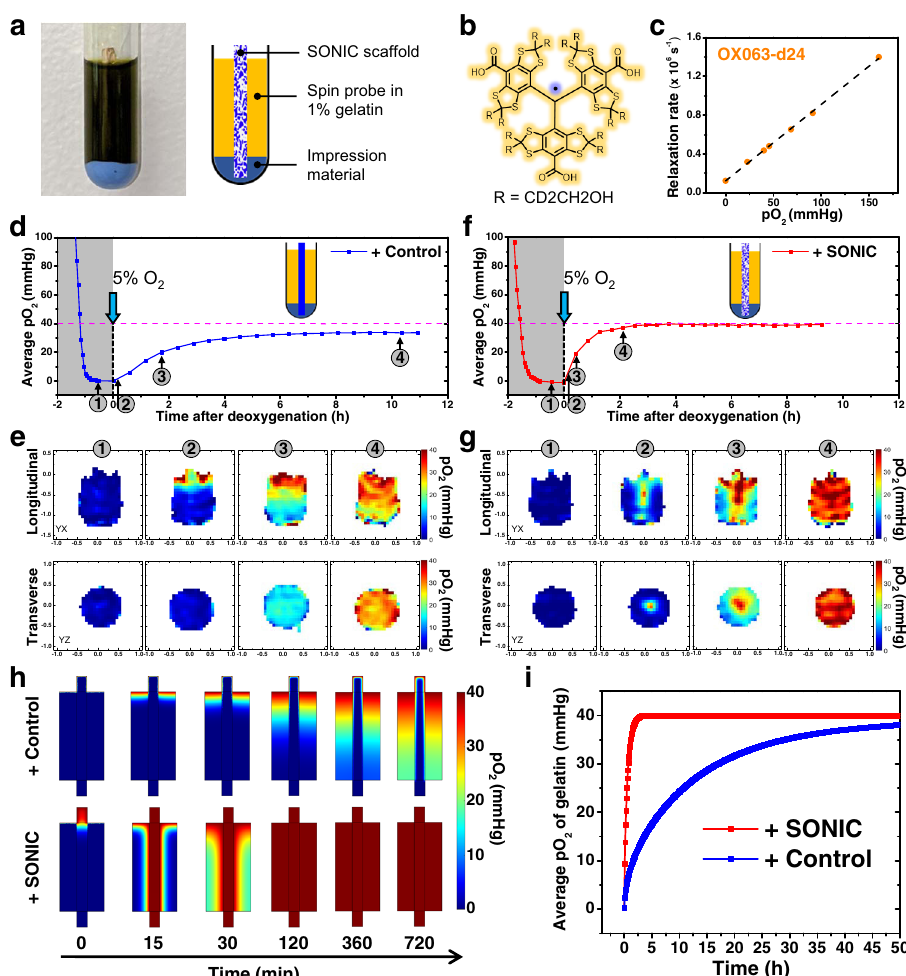
Fig. 3 Characterizations of rapid O 2 transport through the SONIC scaffold. a A digital image (left) and schematic (right) showing the sample in a container for the EPR test. b Chemical structure of the EPR spin probe OX063- d 24. c Calibration curve of the OX063- d 24 relaxation rate versus pO 2 . d Average pO 2 of gelatin in the container with a PLA control insert versus time. The initial gray period indicates the deoxygenation of the system. e pO 2 distributions on the tangential plane and transverse plane of a sample with the PLA control insert at different time points (indicated by the arrows in Fig. 3d). f Average pO 2 of gelatin in the container with a SONIC scaffold versus time showing much faster equilibration. g pO 2 distributions on a tangential plane and a transverse plane of the sample with the SONIC scaffold at different time points (indicated by the arrows in Fig. 3f). h Simulation data showing spatial pO 2 pro fi les over time in the system with the PLA control insert and SONIC scaffold. i Simulated the average pO 2 of gelatin in the container versus